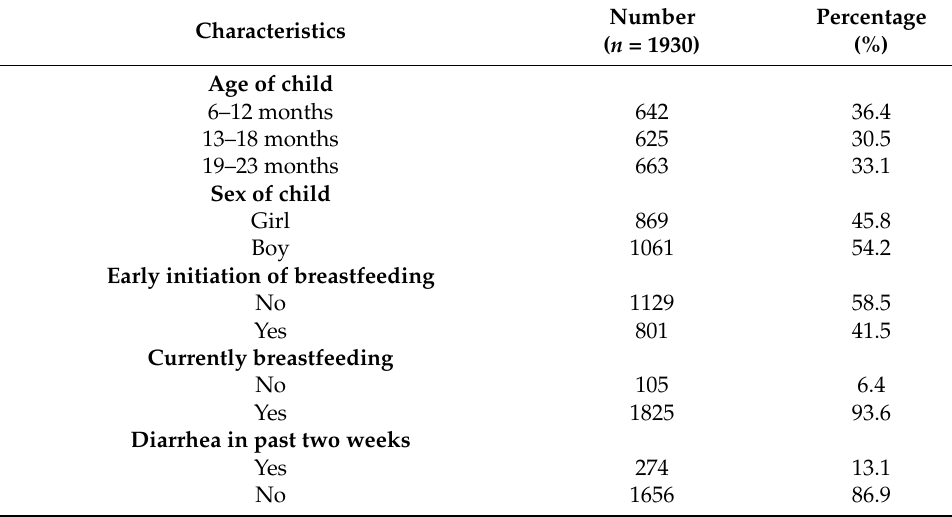
Table 2. Socio-demographic and healthcare-related characteristics of study